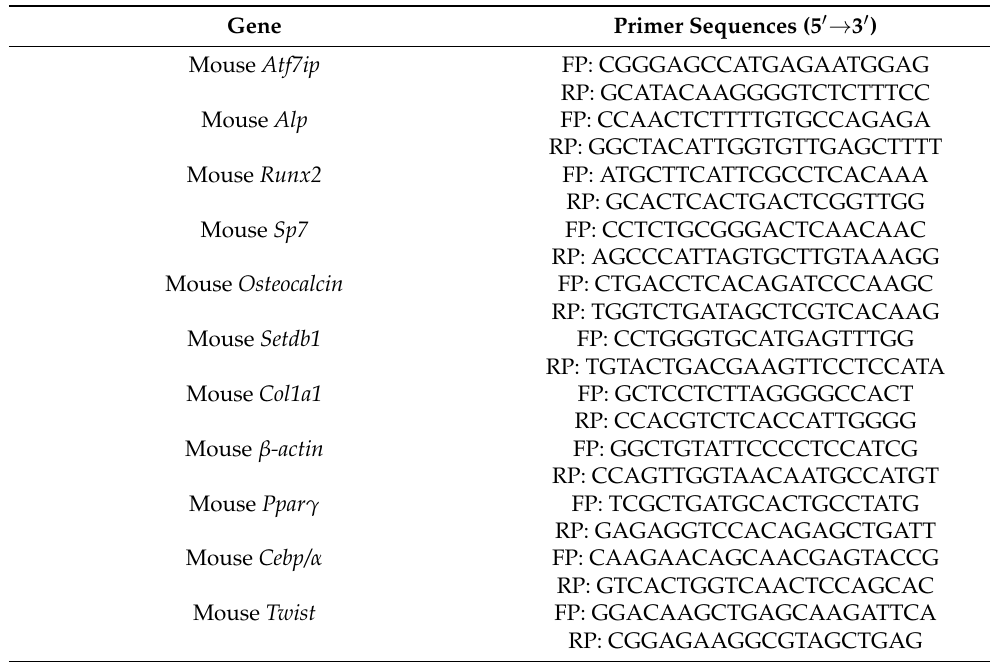
Table 1. Sequences of PCR primers used in